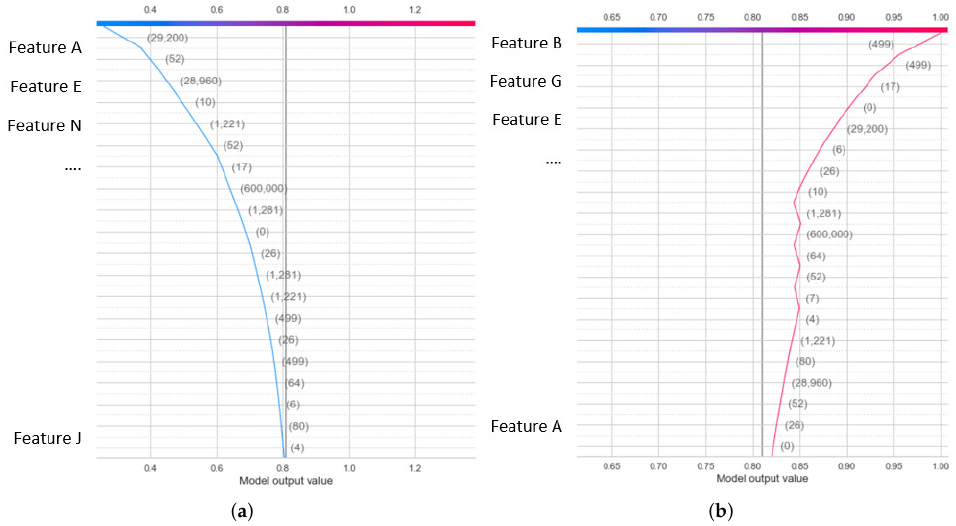
Figure 2. Examples of decision plot. ( a ) Left given the forces of predictors. ( b ) Right give the forces of predictors.